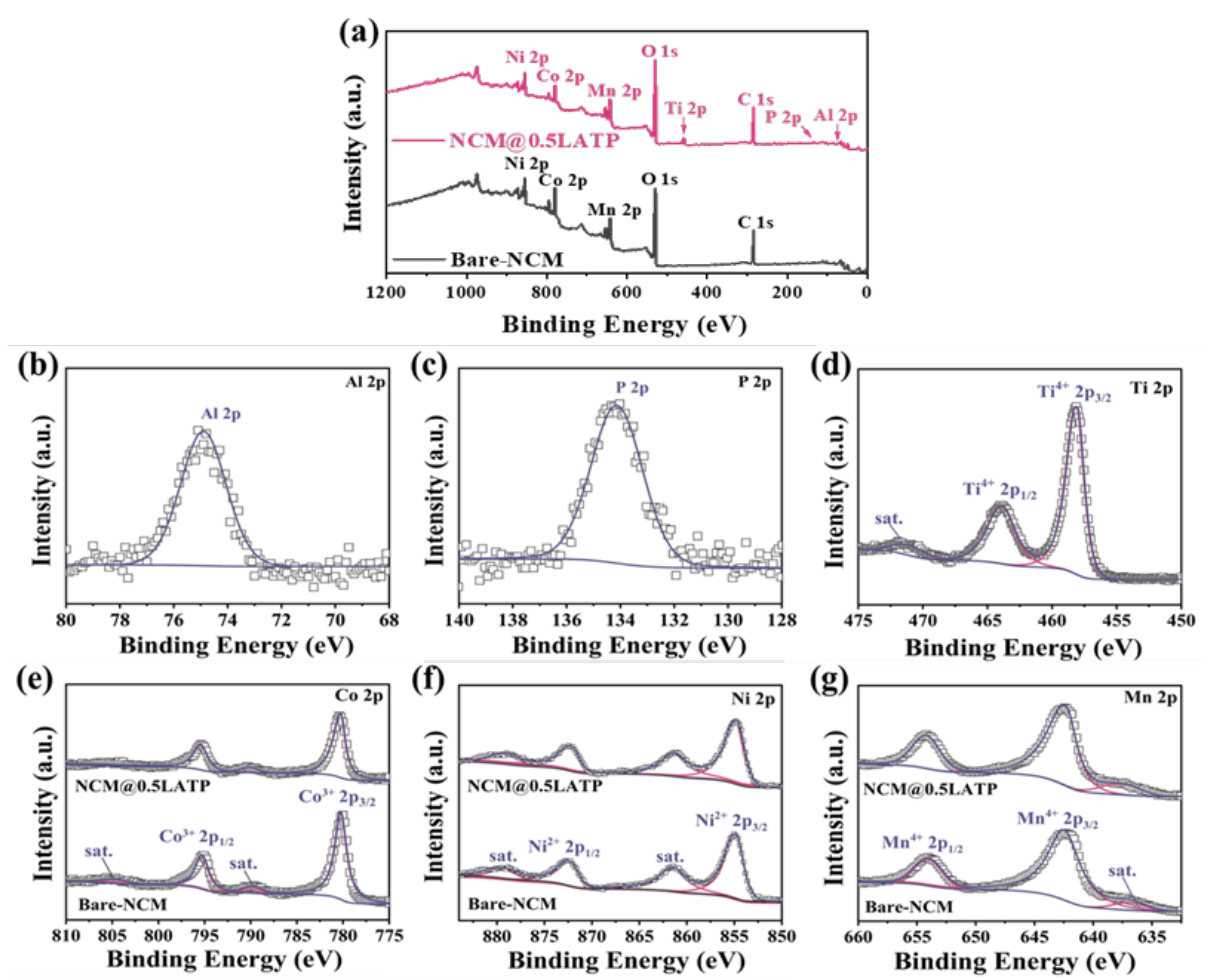
Figure 5. XPS spectra of ( a ) bare NCM and NCM@0.5LATP; high resolution spectra of ( b ) P 2p, ( c ) P 2p, ( d ) Ti 2p for NCM@0.5LATP, and ( e ) Co 2p, ( f ) Ni 2p, and ( g ) Mn 2p for bare NCM